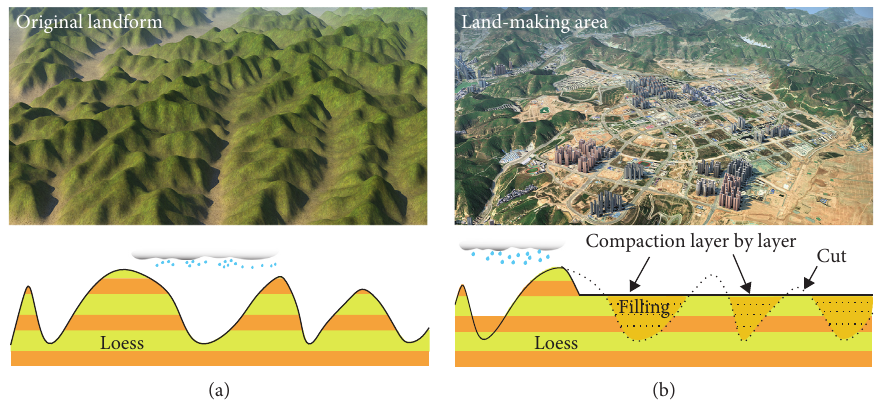
Figure 1: Overview of land-making area: (a) original landform; (b) after cutting and